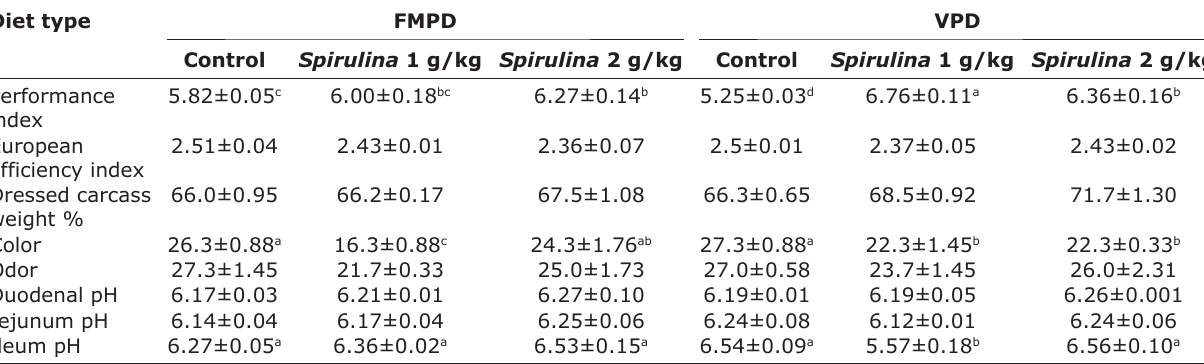
Table-4: PI, EEI, dressed weight %, meat quality and intestinal pH of experimental groups. Diet